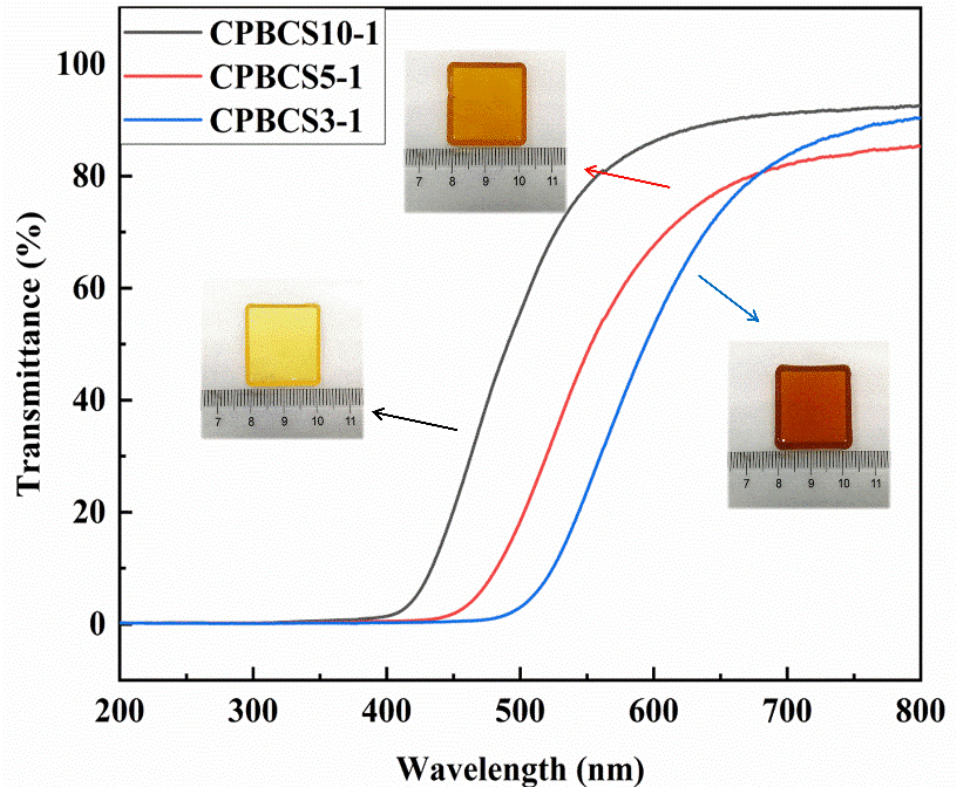
Figure 4. Digital images and UV-Vis transmission spectra of cross-linked CPBCS10-1, CPBCS5-1, and CPBCS3-1 polymers solids.